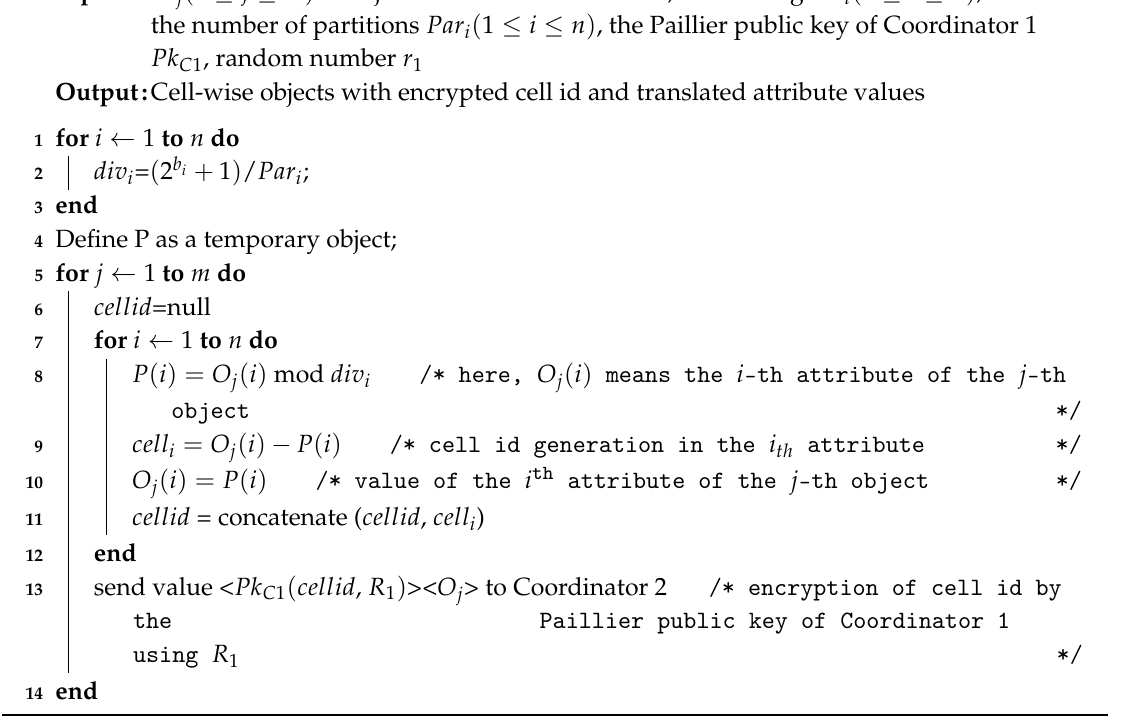
Algorithm 1: Cell-wise object generation with encrypted cell id and translated attribute